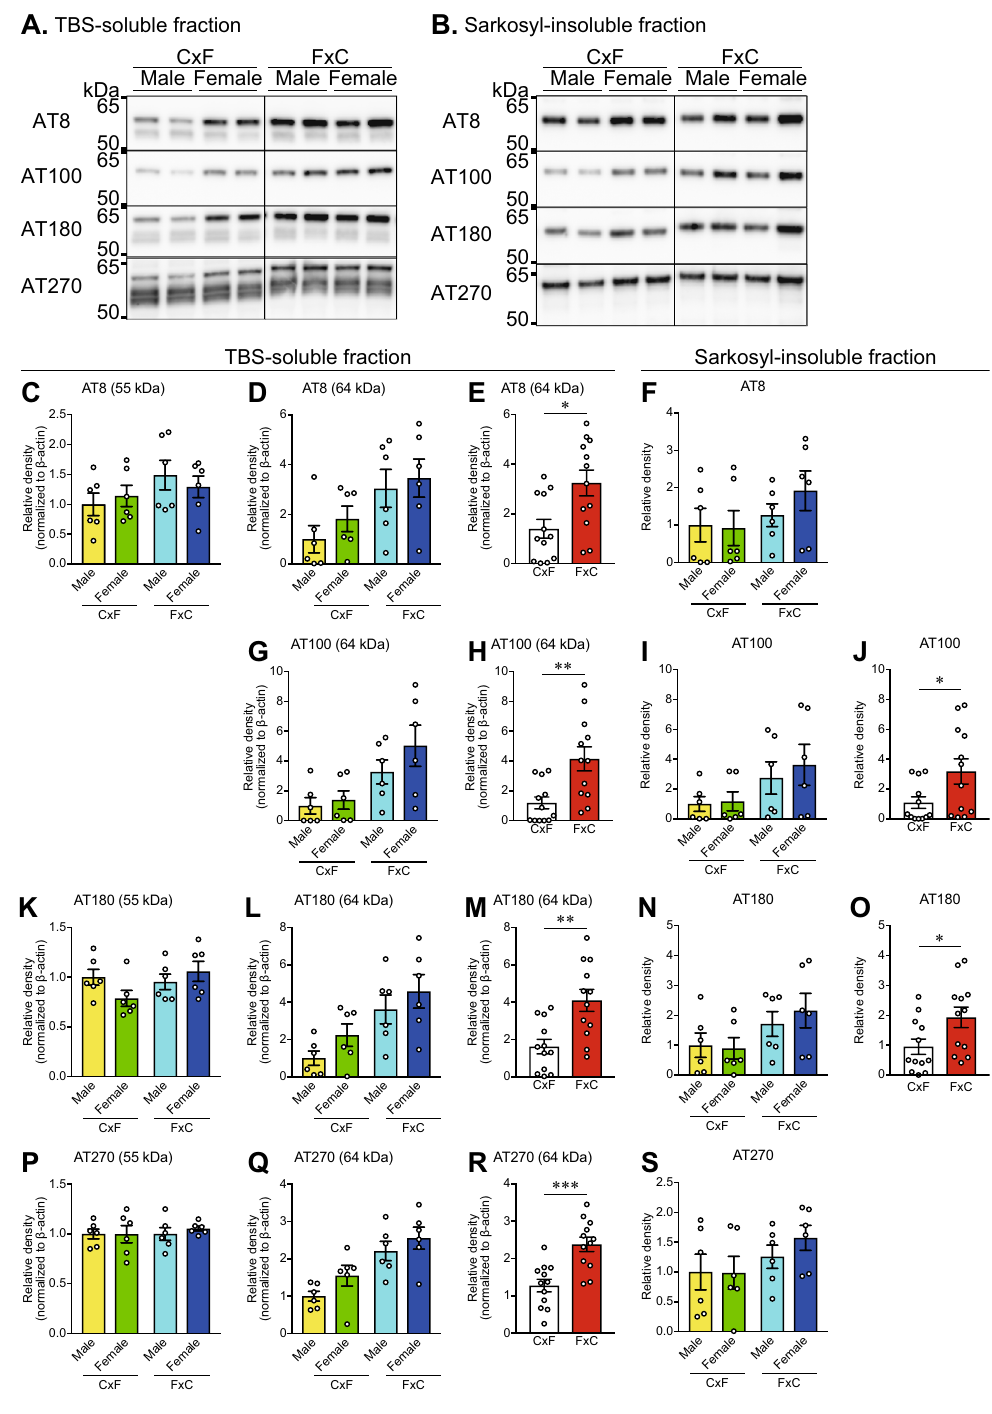
Figure 3. Accumulation of abnormally phosphorylated tau in rTg4510 mice at 6 months of age. ( A , B ) Representative images of western blots of phosphorylated tau (AT8, AT100, AT180, and AT270) in the TBS-soluble fraction ( A ) and sarkosyl- insoluble fraction ( B ) from the cerebral cortex. The band images of each row were obtained from same gel with separation of the CxF and FxC samples. Full-length blots are presented in Supplementary Figure S12. ( C – S ) Densitometric analysis of phosphorylated tau. Two-way ANOVA (genetic background × sex) revealed a main effect of the genetic background, but no effect of sex, on the levels of AT8 ( D ), AT100 ( G ), AT180 ( L ), and AT270 ( Q ) at 64 kDa in the TBS-soluble fraction, and AT100 ( I ) and AT180 ( N ) in the sarkosyl-insoluble fraction (Supplementary Table S1). The Mann–Whitney U test revealed significantly higher levels of AT8 ( E ), AT100 ( H ), AT180 ( M ), and AT270 ( R ) at 64 kDa in the TBS-soluble fraction and AT100 ( J ) and AT180 ( O ) in the sarkosyl-insoluble fraction of the rTg4510_FxC mice, as compared with the rTg4510_FxC mice. The rTg4510_CxF and rTg4510_FxC groups contained six males and six females each ( n = 12/group). Data are presented as mean ± SEM. *** p < 0.001, ** p < 0.01, * p < 0.05 (Mann–Whitney U